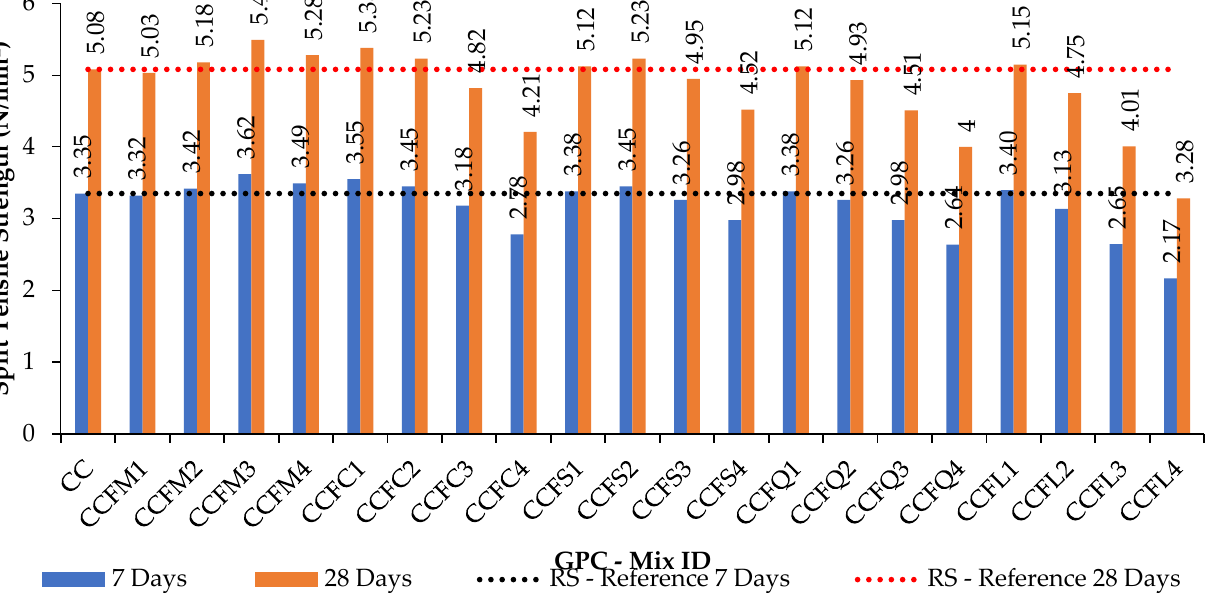
Figure 8. The 7- and 28-day split tensile test results for M 40 CC with various fine aggregates. Considering the GPC test results, keeping the control specimen as a benchmark, M-sand at all replacement levels, copper slag at 50% replacement, and quarry dust at 25% obtained an increase in strength. Beyond 50% of copper slag and 25% of quarry dust, a decrease in strength was found at GPC. Limestone sand as the fine